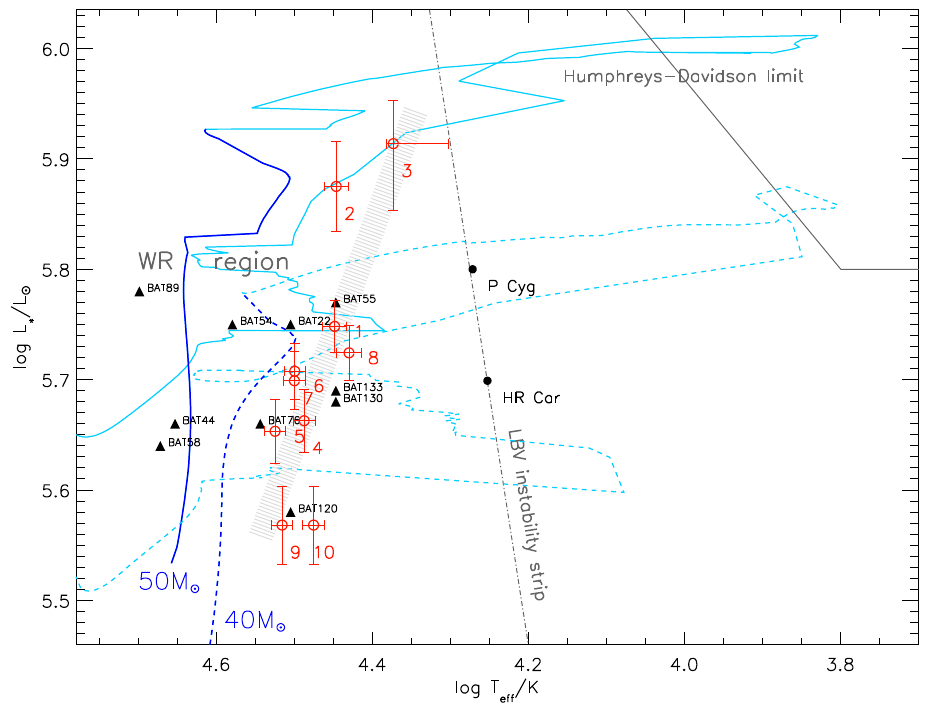
Figure 8. Position of GR290 in the Hertzsprung-Russell diagram at different times. Numbers correspond to: (1) October 2002; (2) February 2003; (3) January 2005; (4) September 2006; (5) October 2007; (6) December 2008; (7) October 2009; (8) December 2010; (9) August 2014; and (10) July 2016 and September 2018. The hatched strip shows an average line along which GR 290 moved during its recent luminosity cycles. The Geneva tracks [51] for 40 M (cid:12) (dashed line) and 50 M (cid:12) (solid line) with rotation are shown by blue lines, with dark blue part corresponding to the hydrogen burning in stellar core. Triangles mark the positions of late-WN stars from Large Magellanic Cloud (LMC), whose data were taken from Hainich et al. [52]. In addition, the positions of LBV stars PCygni and HRCar are shown with circles. Data for these objects were taken from the works of Najarro [53] and Groh et al. [54]. Grey solid line is Humphreys-Davidson limit [3], grey dash-dotted line is LBV minimum instability strip as defined in